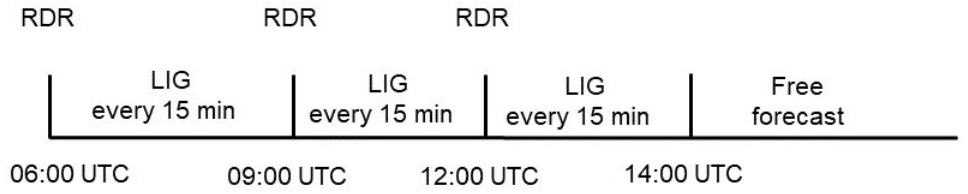
Figure 6. Data assimilation strategy for the RDR-LIG